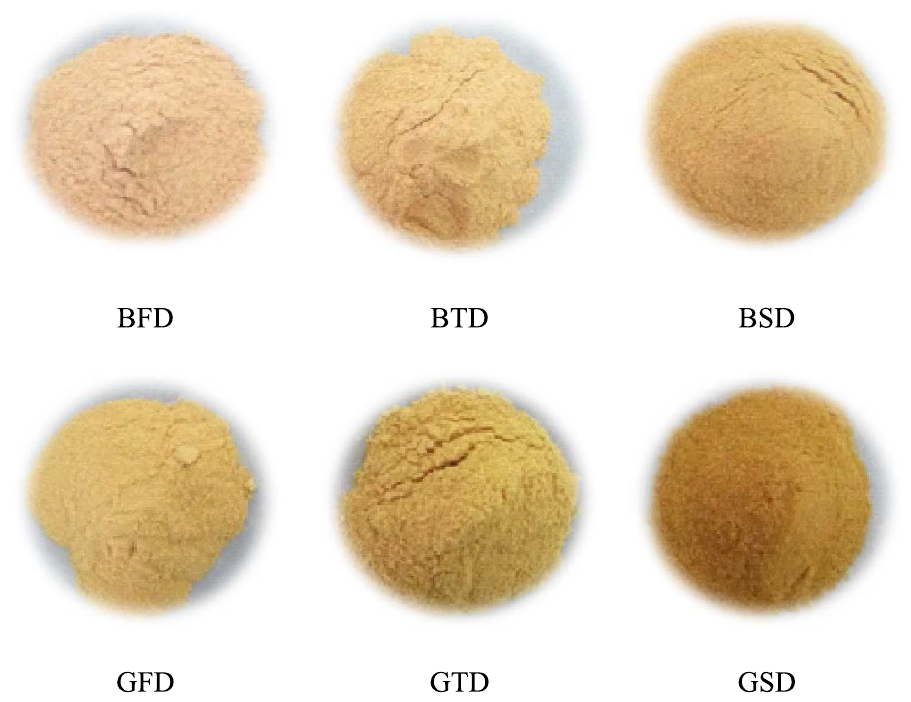
Figure 1. Different dried pomegranate peel powders. where BFD Bhagwa freeze-dried, BTD Bhagwa tray- dried, BSD Bhagwa sun-dried, GFD Ganesh freeze-dried, GTD Ganesh tray-dried, GSD Ganesh